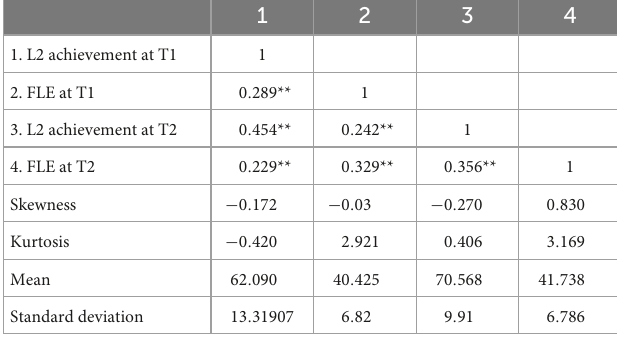
TABLE 1 Spearman correlations of the study